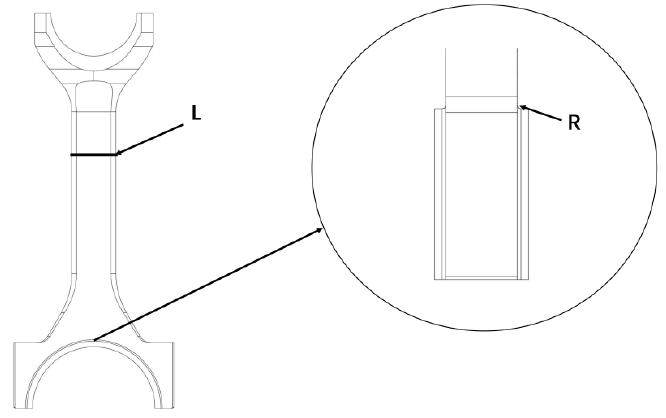
Figure 17. Schematic diagram of optimization.